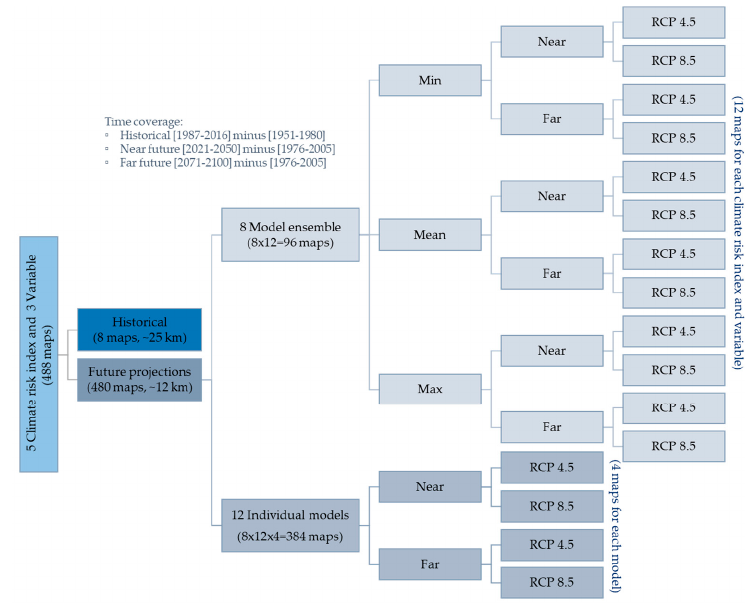
Figure 1. Diagram showing the structure of the climate maps creation.